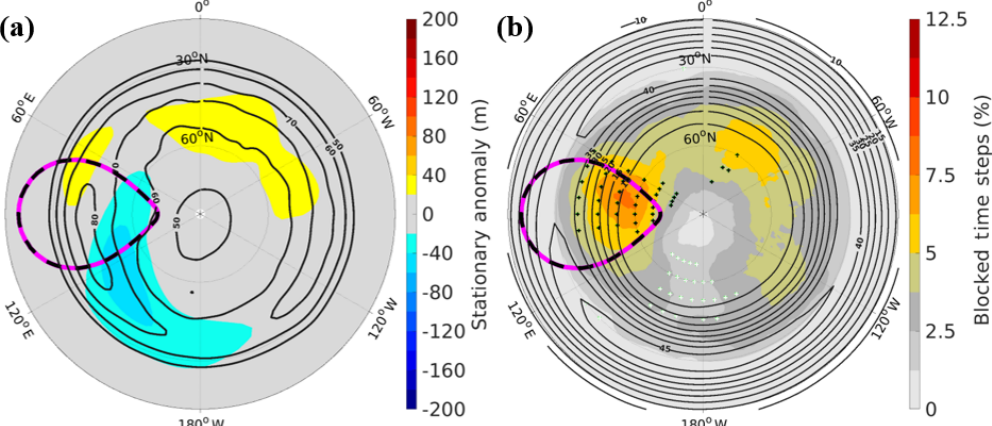
Figure 9. For an integration with one flat landmass, (a) the cool-season stationary wave (shading) and storm track (heavy black contours) and (b) the cool-season blocking climatology (shading) and U 250 (heavy black contours). In (a) storm track contours are in 10m intervals where the outer contour is 50m. In (b) U 250 contours are in 5ms − 1 intervals where the outer contour is 10ms − 1 . Black (white) stippling in (b) indicates significantly greater (lower) block frequency at nearby grid points when compared to a 250-year aquaplanet integration. The dotted pink and black contours represent the outer edge of the land